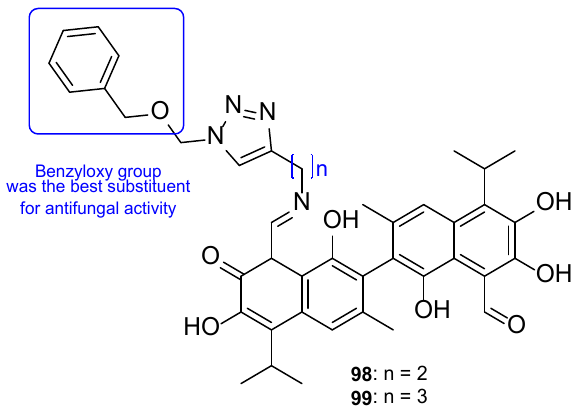
96 : R = 97 : R = Figure 47. Chemical structures of compounds 96 and 97 [131].